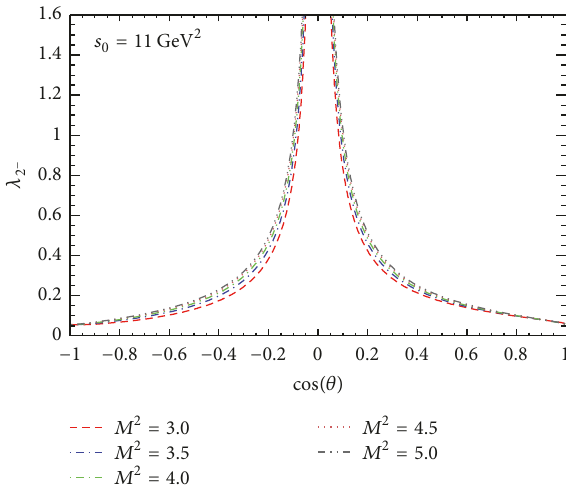
Figure 2: Same as in Figure 1, but for Ω 𝑐 (3050)